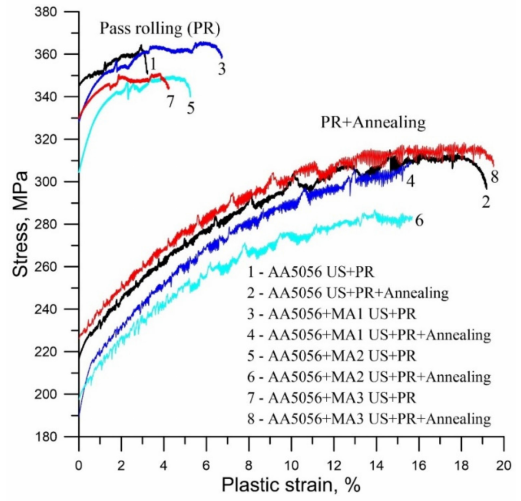
Figure 9. Stress-strain diagrams of aluminum alloys with master alloy additions MA1–MA3 after pass rolling and